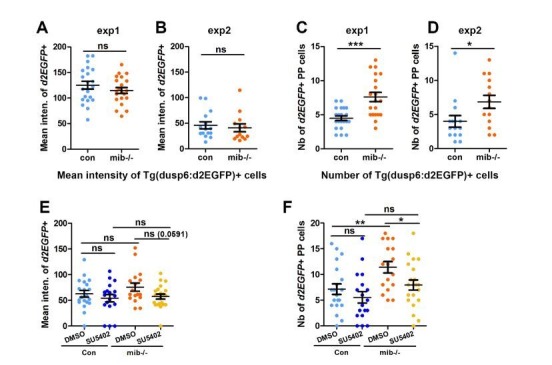
The number but not the mean intensity of Tg(dusp6:d2EGFP) expressing cells is increased in mib-/- mutants.(A-B) Dot plots showing the mean GFP fluorescence intensity (A, B) of Tg(dusp6:d2EGFP) expressing parapineal cells in the first (A) and second experiment (B) in controls (blue dots; A, n=21; B, n=15) or in mib-/-mutant embryos (orange dots; A, n=21; B, n=13) at 32 hpf stage. (C-D); we chose to present data for the 2 experiments separately as the mean intensity threshold chosen to define Tg(dusp6:d2EGFP)+ cells differ between both experiments. (C-D) Dot plots showing the number of Tg(dusp6:d2EGFP) expressing parapineal cells in the first (C) and second experiment (D); merged data for both experiments are presented in the Manuscript as Figure 1E. (E-F) Dot plots showing the mean fluorescence intensity of Tg(dusp6:d2EGFP) expressing parapineal in control embryos treated with DMSO(light blue; A, n=20) or with 5 µM SU5402 (dark blue; A, n=18), and in mib-/-mutant embryos treated with DMSO (orange; A, n=17) or with SU5402 (yellow; A, n=21) at 32 hpf stage. Mean ± SEM is indicated; ns, p-value>0,05; * p-value<0,05; ** p-value<0,01 in Welch t-test.